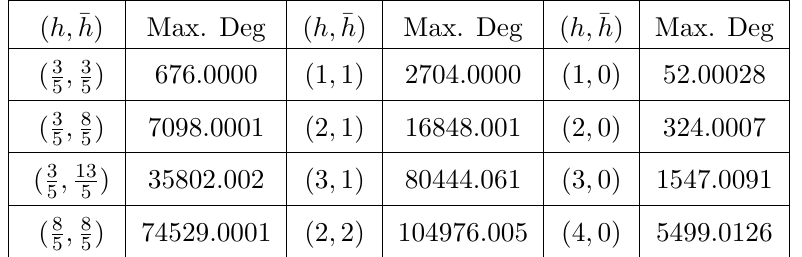
Table 5. The maximum value of degeneracies for low-lying states in a putative CFT with c = 26